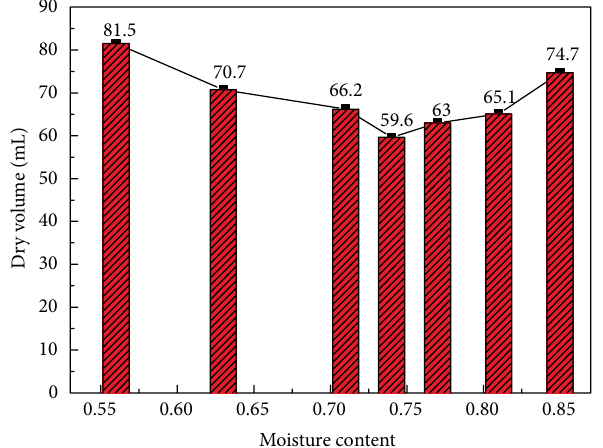
Figure 9: Dry volume of solidified sludge with different initial moisture